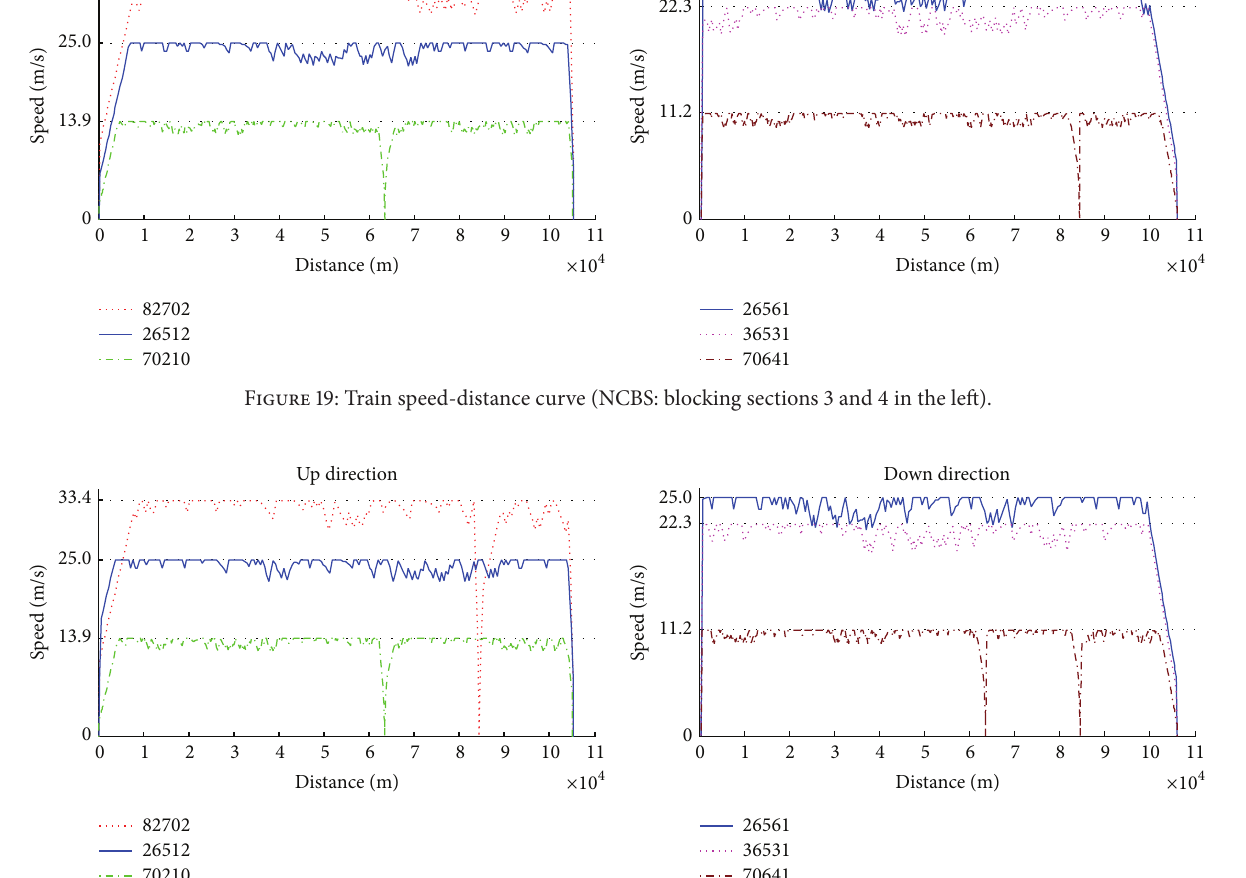
down directions, respectively. Compared with OGT running without NCBS, the zone occupation time increases by 4.4% and capacity loss is 0.81 trains in the up direction, while the zone occupation time increases by 13.9% and capacity loss is 3.02 trains in the down direction.